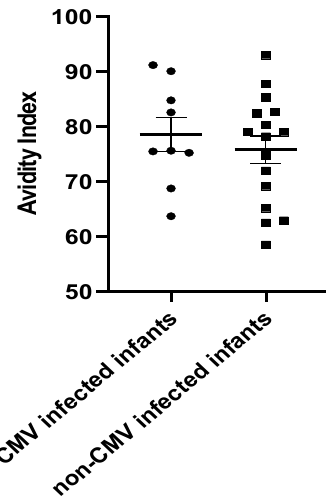
Figure 5. IgG Avidity Index for CMV-infected ( n = 9) and control infants ( n = 16). The bold line represents the mean and error bars of the SEM. The median for CMV-infected infants was 75.60% with an IQR of 71.98 – 97.16. The median for the non-CMV-infected infants was 78.59% with an IQR of 66.19 – 93. No evidence for the impact of IgG avidity on the risk of infection was observed. Mann – Whitney test, p = 0.6.